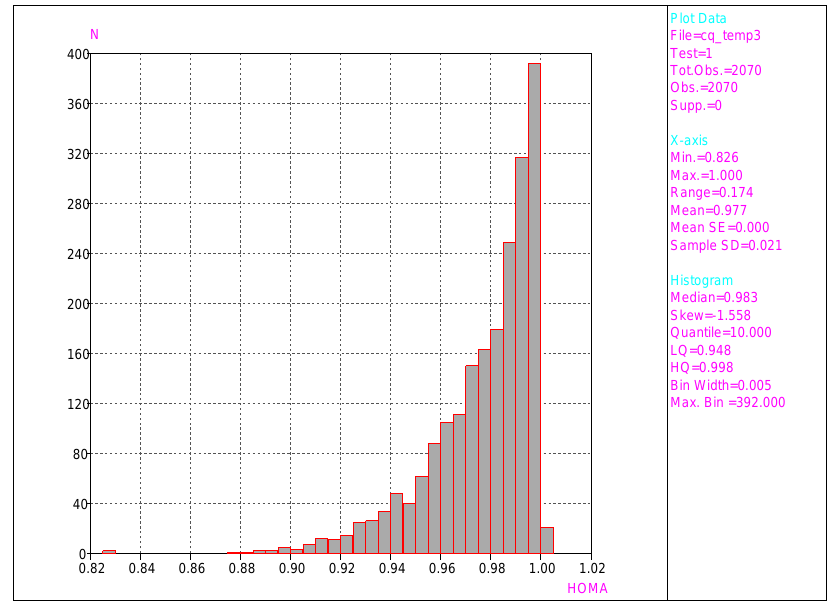
Figure 6. Histogram of the distribution of HOMA data for para -substituted nitrobenzene derivatives.